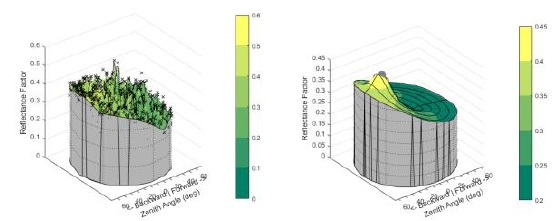
Figure 13. Preliminary HDRFs from the morning data set: the raw observations (left) and the fitted model (right).